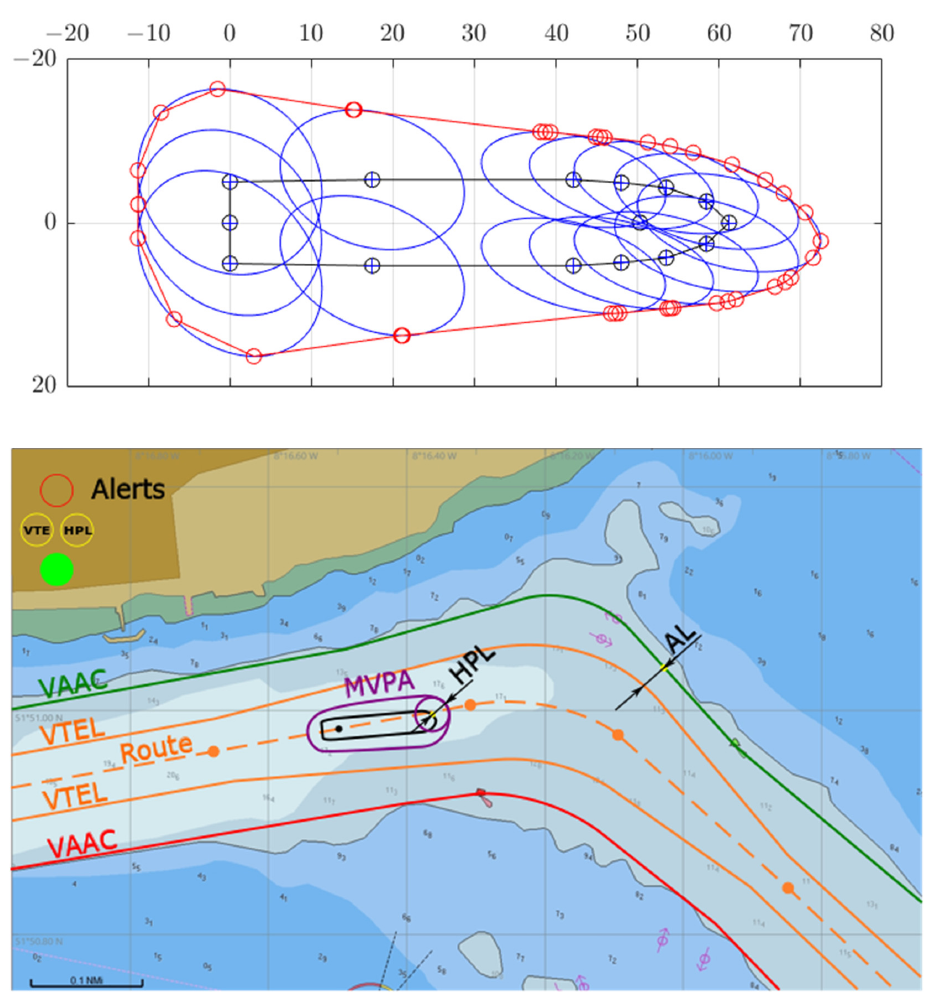
Figure 10. MVPA construction (top) and its application in ECDIS system (bottom) (based on [31]). The relations among PL, AL, and true, unknown, position error (PE) could be inter- preted by the Stanford-ESA diagram [38] (see Figure 11).